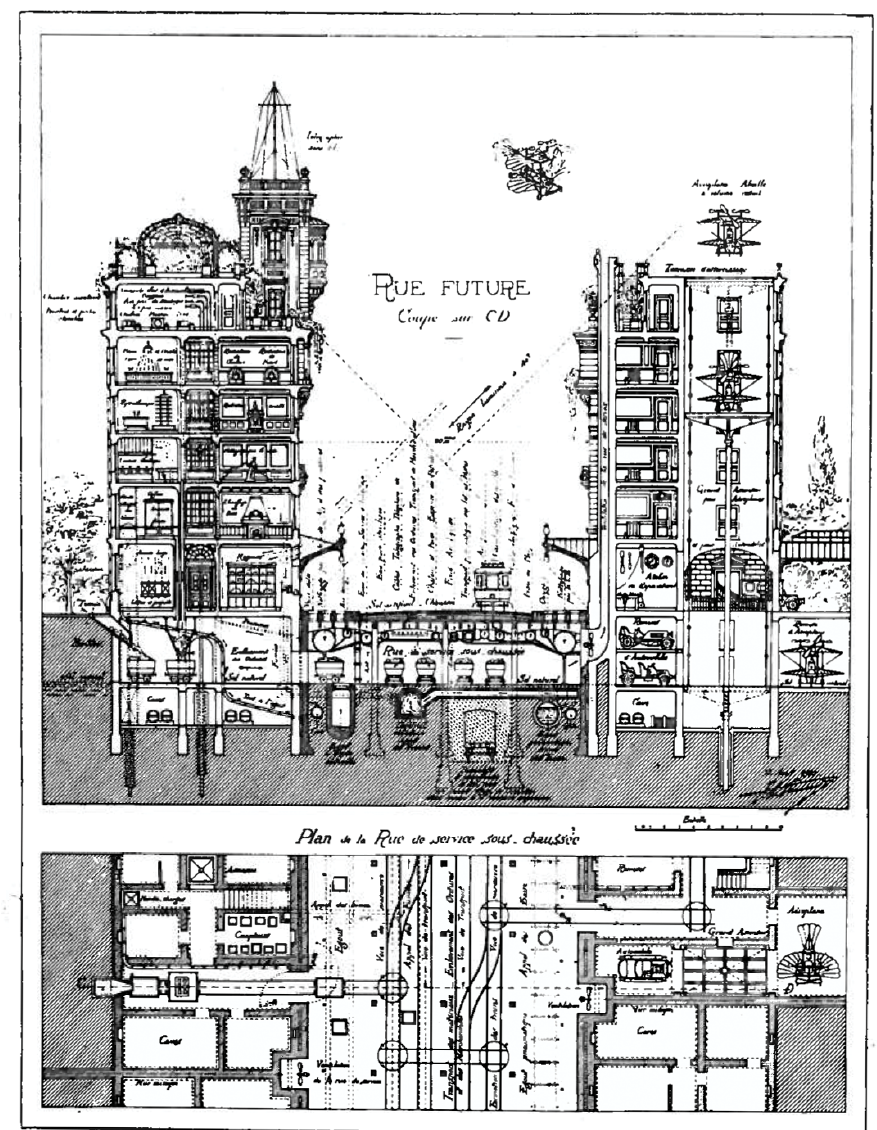
Figure 1. Eugène Hénard’s Rue Future (future street) integrating the underground into a mechanical rationalization of flows of materials and people (Hénard, 1903/1982, p.